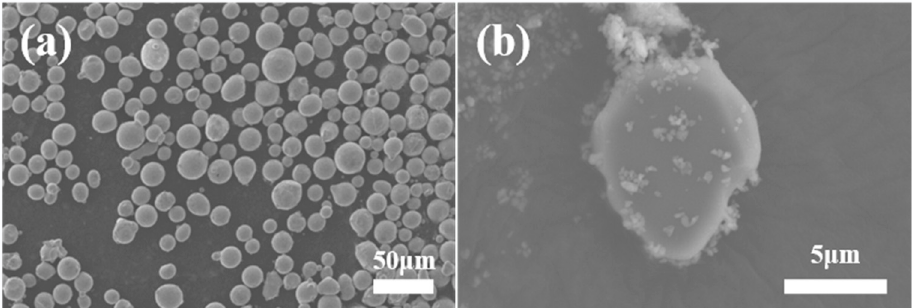
Figure 1. SEM images of powders: ( a ) CoCrMo powder; ( b ) Al 2 O 3 powder.